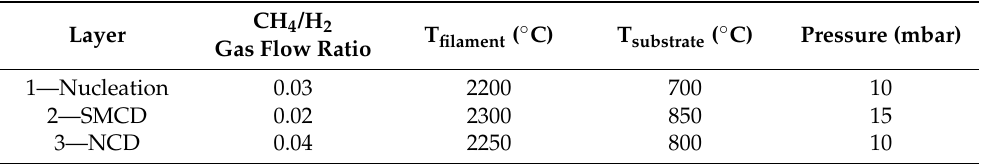
Table 1. Parameters used for diamond growth by